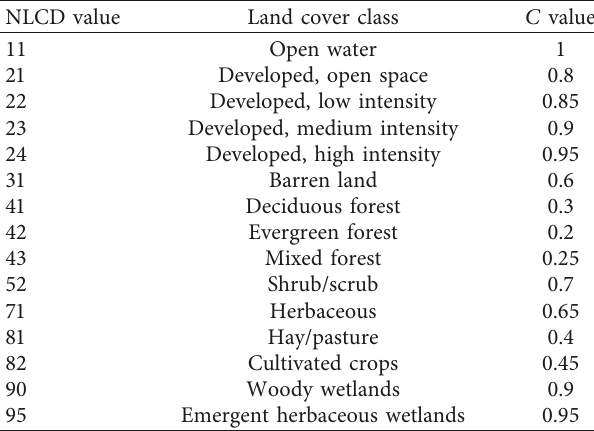
Table 2: Land use attributes and associated C values. NLCD